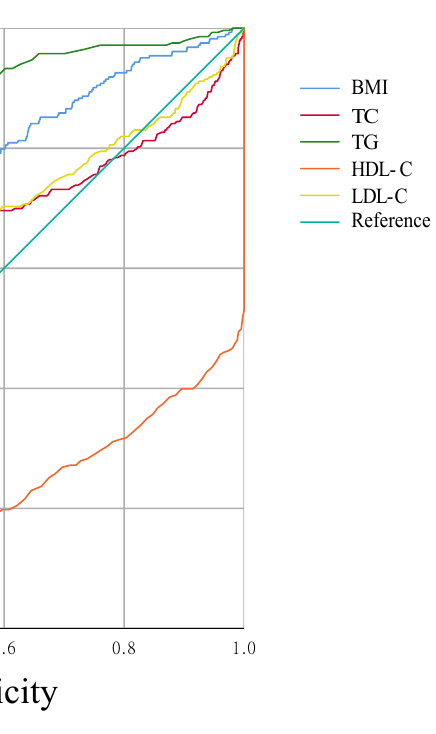
Figure 4. Receiver operator characteristic (ROC) curves for BMI, TC, TG, HDL-C, and LDL-C to predict dyslipidemia. Area under ROC curve = 0.655, 0.645, 0.864, 0.188,